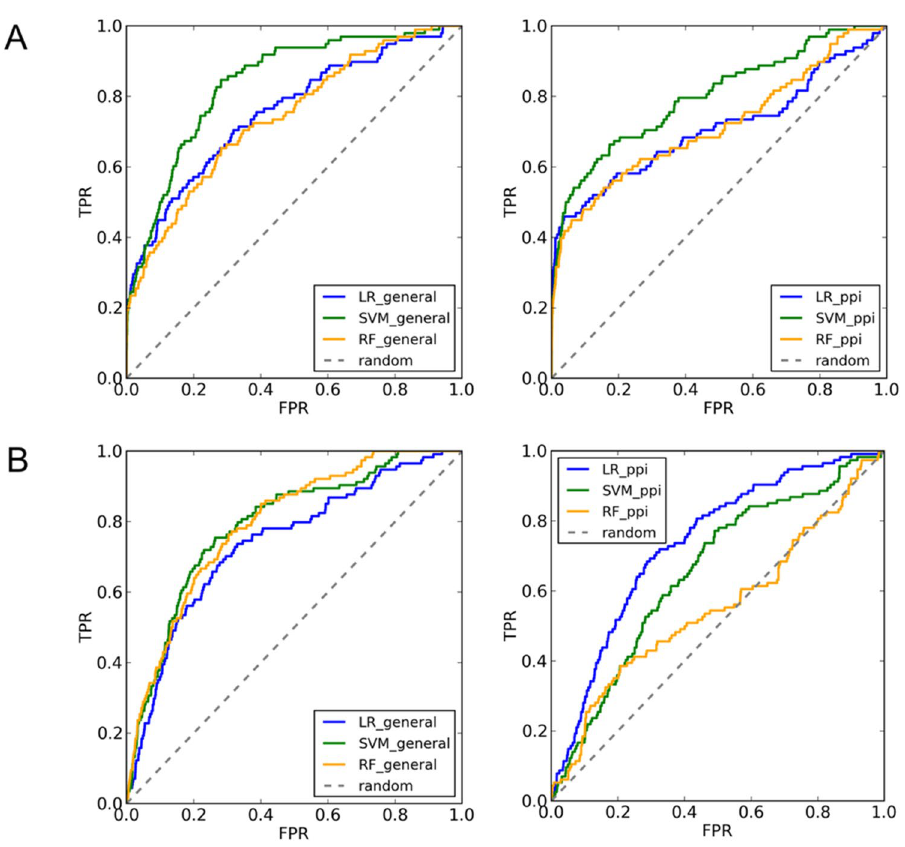
Figure 8. AUC ROC curves of the general (left) and PPI-specific (right) scoring functions trained with MLR, SMOreg and RF for the Bcl2-like/BAX ( A ) and MDM2/p53 ( B )